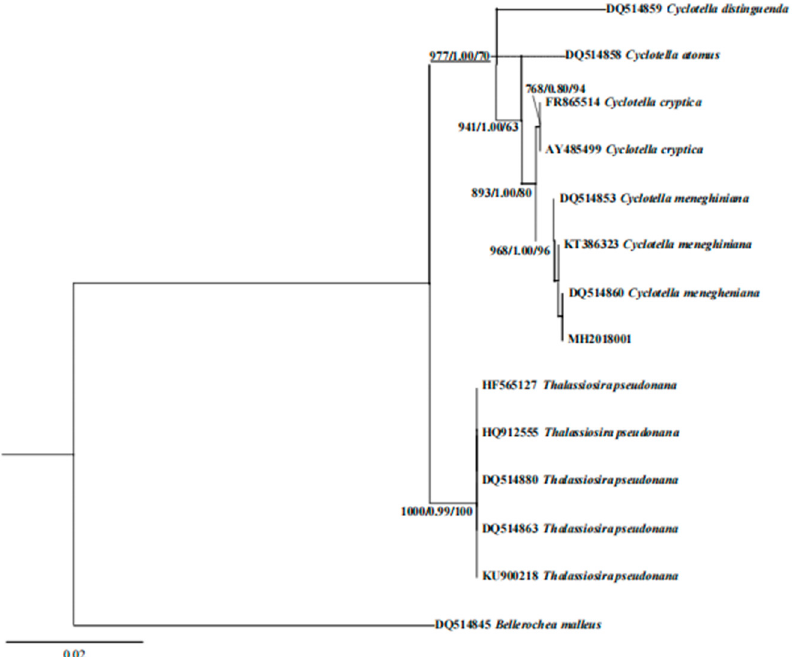
Figure 3. Bayesian analysis tree based on 18S rDNA gene sequence of Cyclotella menegheniana MH2018001. The numerical values at the nodes represent the support values of BI bootstrap/ML bootstrap/NJ bootstrap.